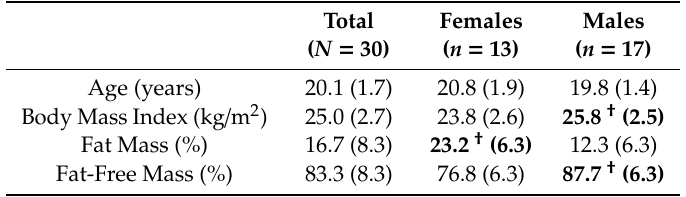
Table 1. Participant descriptive statistics (means and standard deviations).